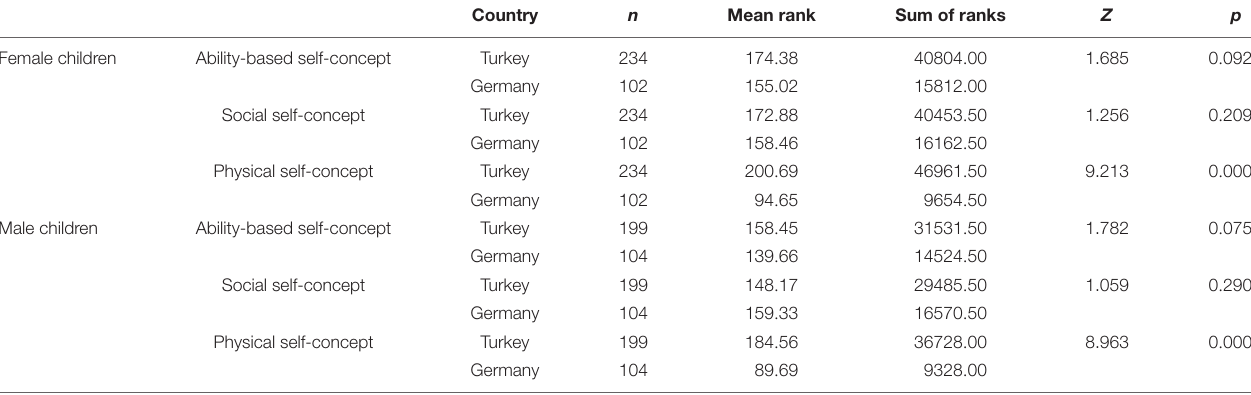
TABLE 7 | Mann–Whitney U test results of the female and male children’s scores in the dimensions of the self-concept questionnaire by country. Country n Mean rank Sum of ranks Z p Female